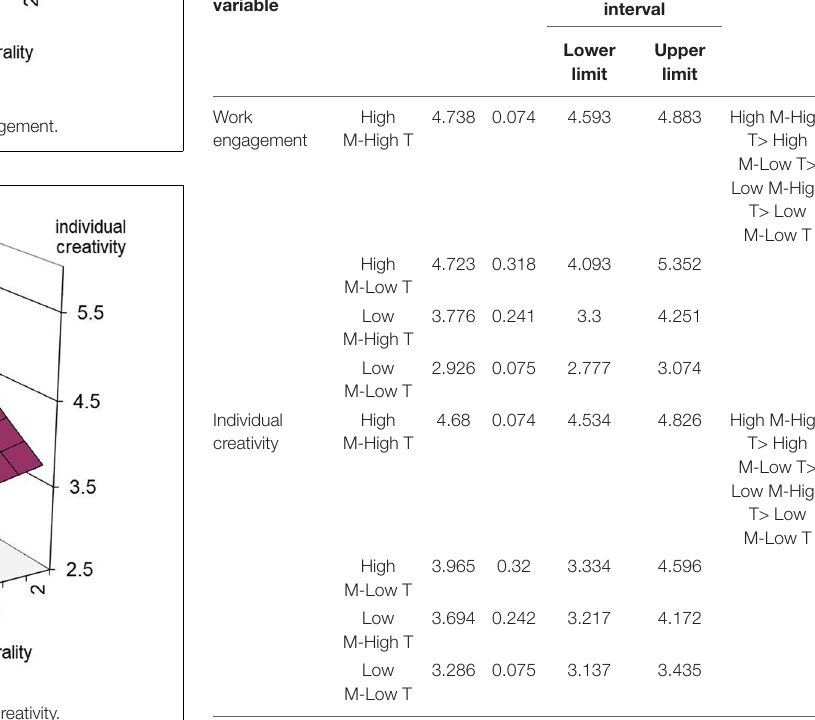
FIGURE 2 | Effects of morality and talent on individual creativity.